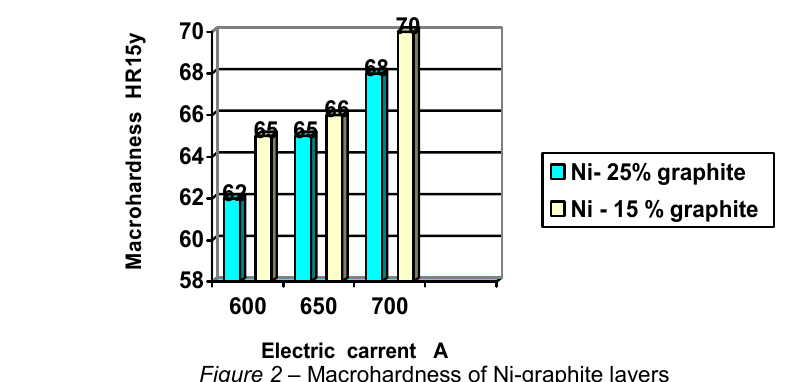
Figure 2 – Macrohardness of Ni-graphite